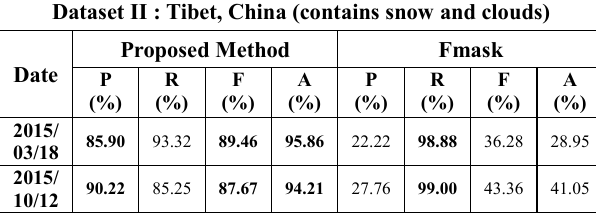
Table 6. Quantitative analysis. Dataset II : Tibet, China (contains snow and